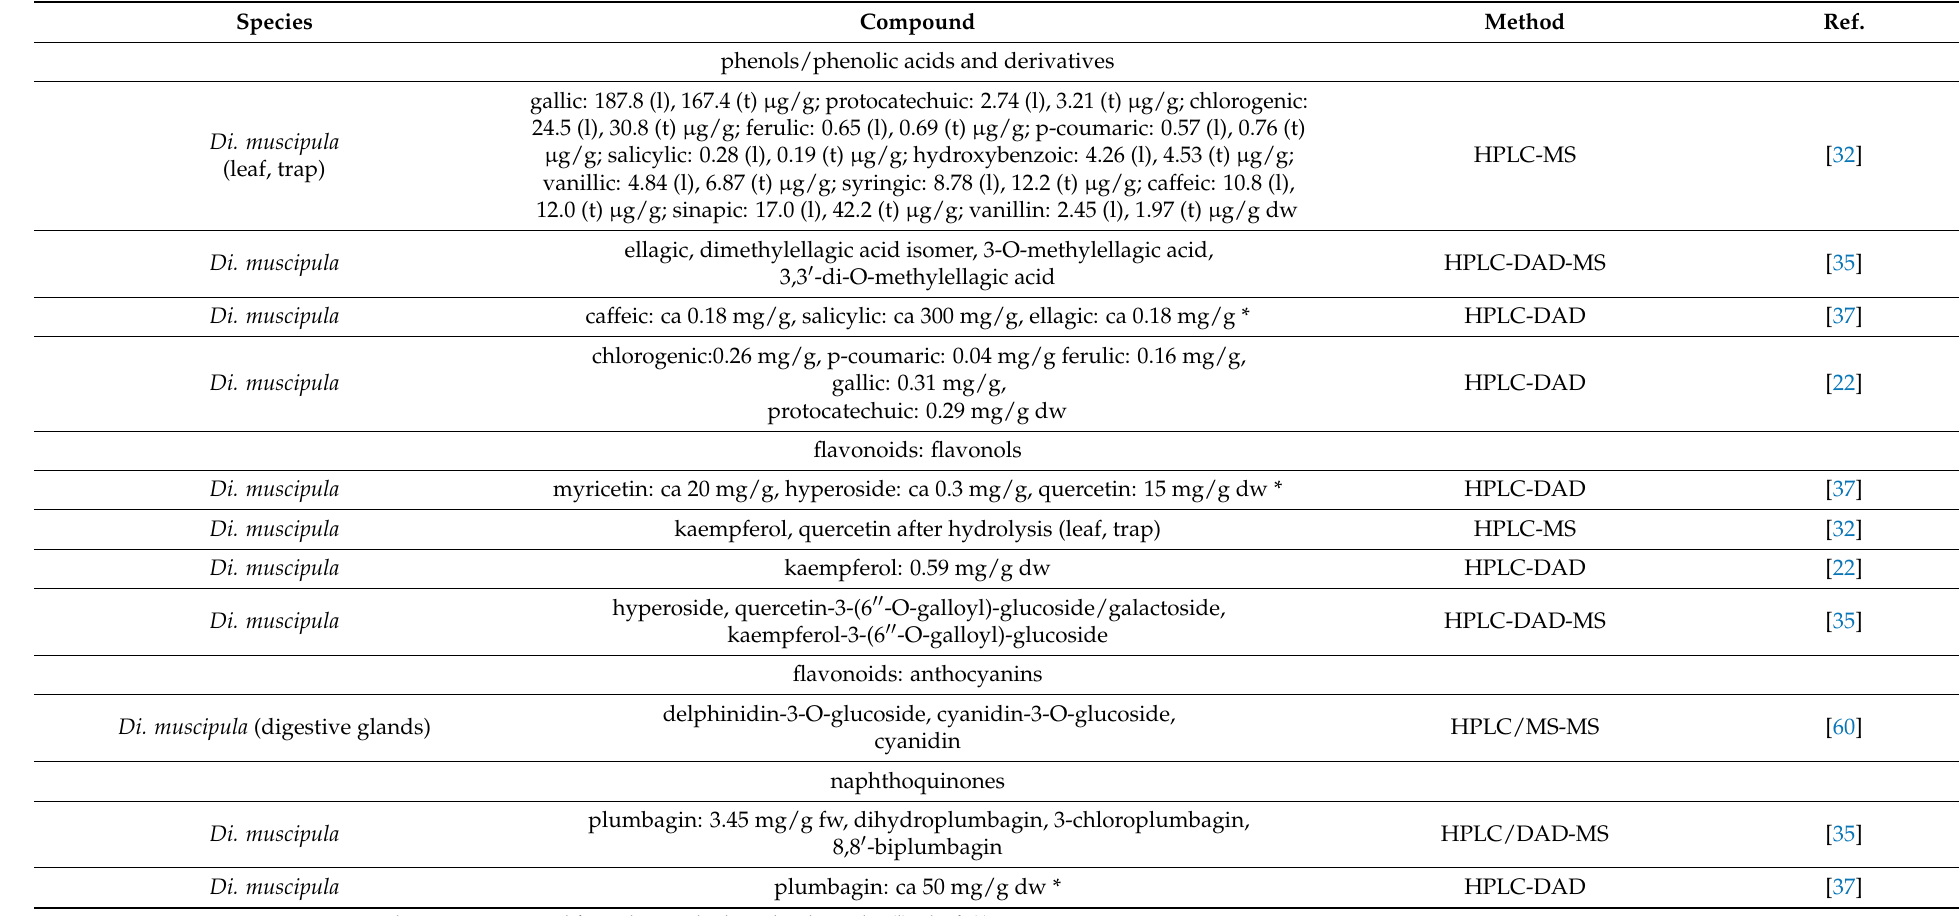
Table 3. Secondary metabolites identified in Dionaea